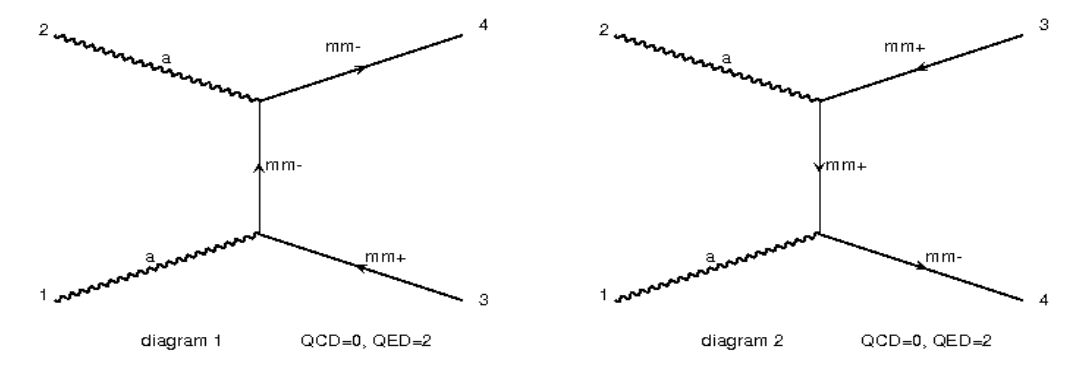
Figure 2. The Feynman Diagrams produced by M AD G RAPH for spin 1 / 2 magnetic monopoles. Here, “mm+” suggests monopole, “mm − ” shows the anti-monopole and “a” describes the